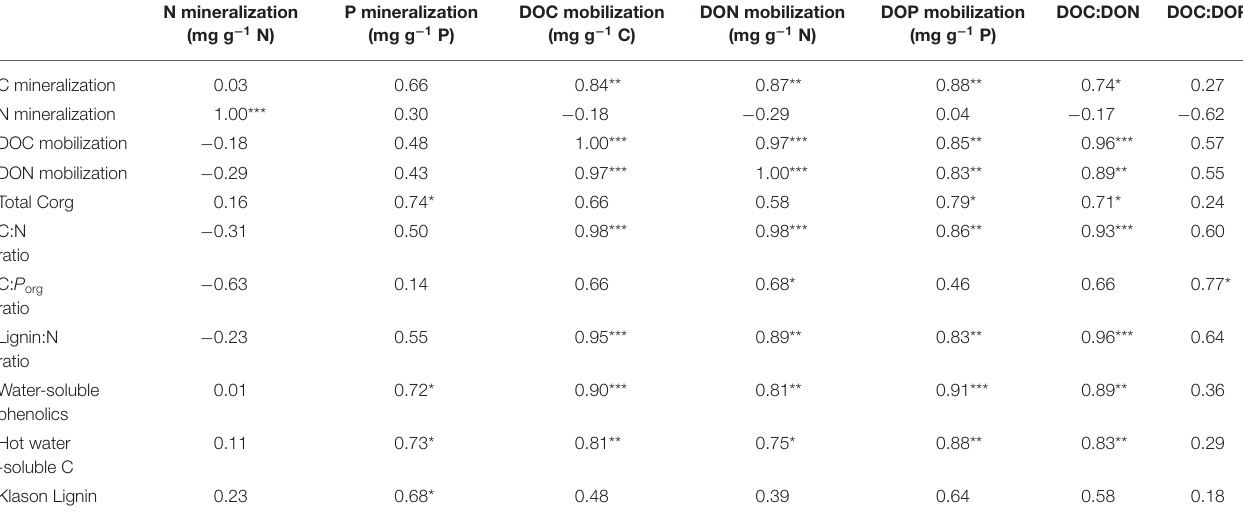
TABLE 5 | Pearson correlation coefficients (r), between cumulative C mineralization, N-mineralization, P mineralization, DOC mobilization, DON mobilization, DOP mobilization, DOC:DON, and DOC:DOP ratios in leachates, and chemical characteristics of the nine soil horizons. N mineralization (mg g − 1 N)